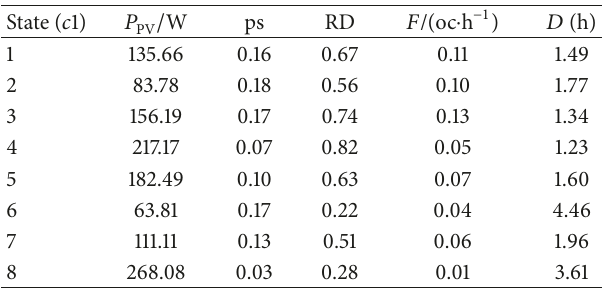
Table 3: Markov model of load.